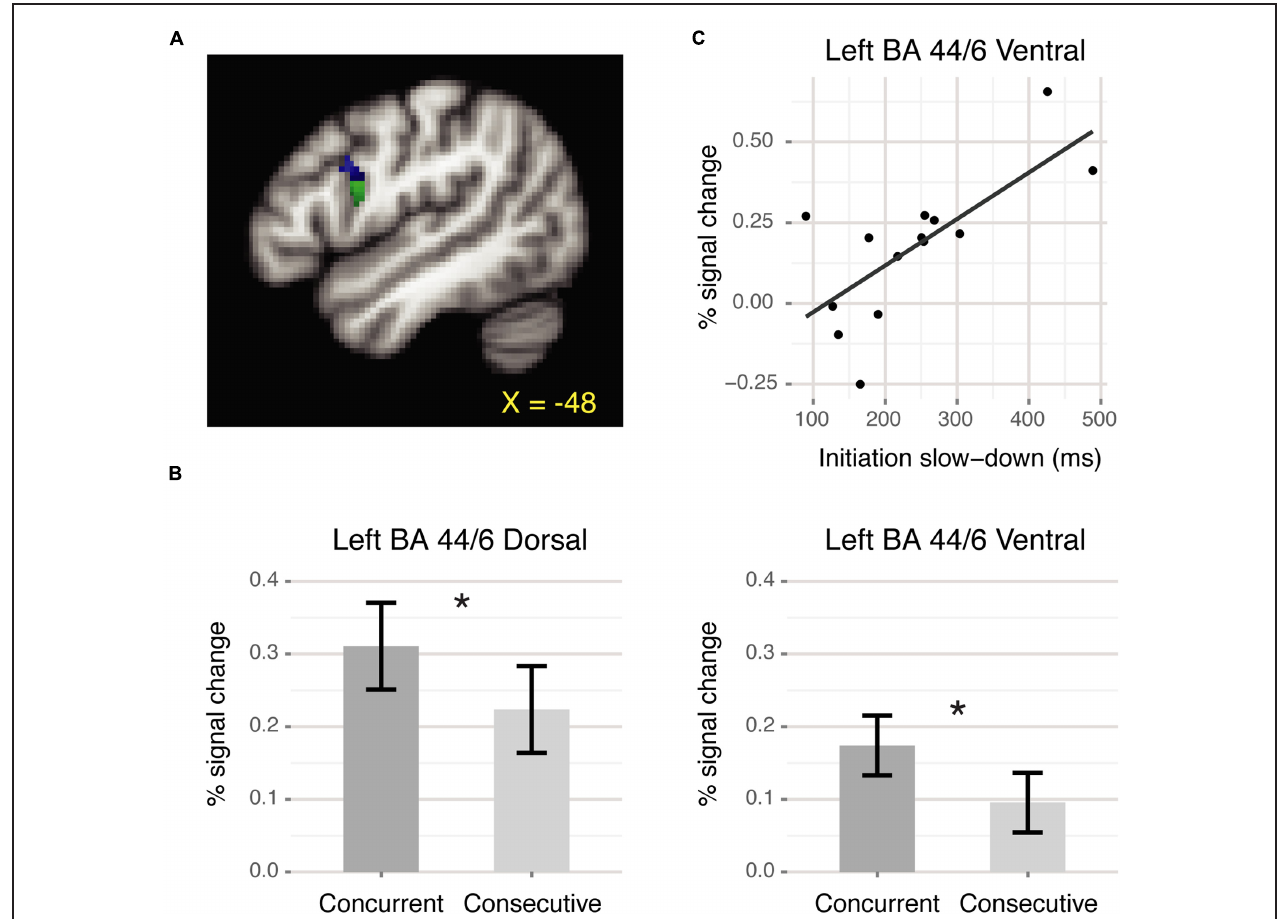
FIGURE 2 | BA 44/6 ROI results. (A) Dorsal (blue) and ventral (green) ROIs at the premotor-prefrontal junction. (B) Mean percent signal change for each condition relative to baseline. Both ROIs showed significantly greater activation for the concurrent than the consecutive condition ( ∗ p < 0.05). Error bars denote corrected Cousineau confidence intervals (Morey, 2008). (C) Positive correlation between slowed response initiation and neural activation within ventral BA 44/6 during the concurrent